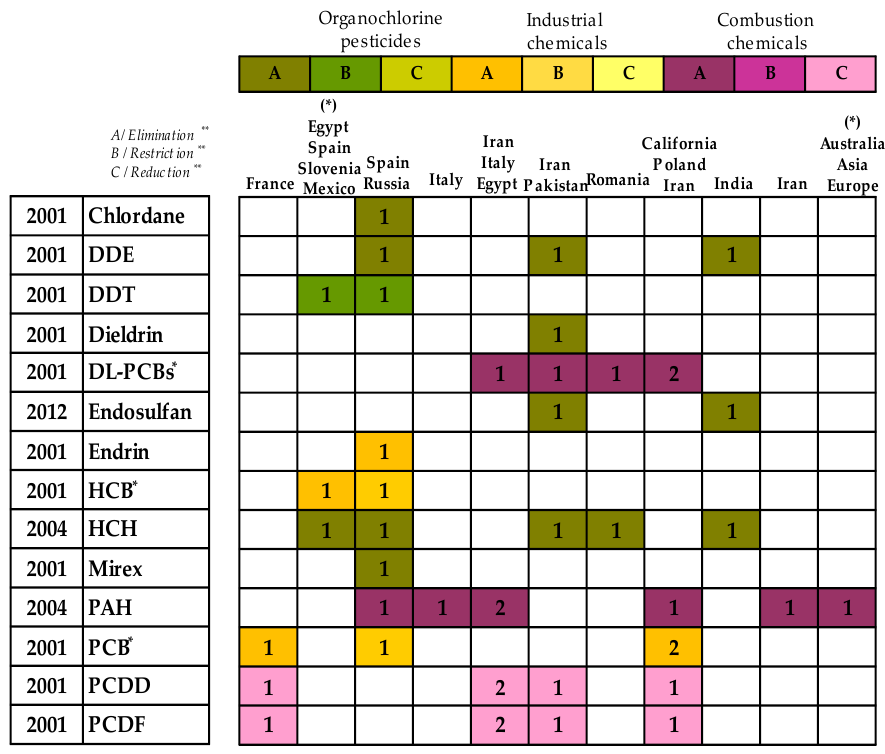
Figure 2. POPs presence in milk (including the number of reporting articles). Classification conducted in relation to the measures applied by the Stockholm Convention (**). The dates on the Y axis indicates the year when the chemical compound was included in one of the annexes of the Stockholm Convention. Some POPs are part of Annex A and also of Annex C (*).